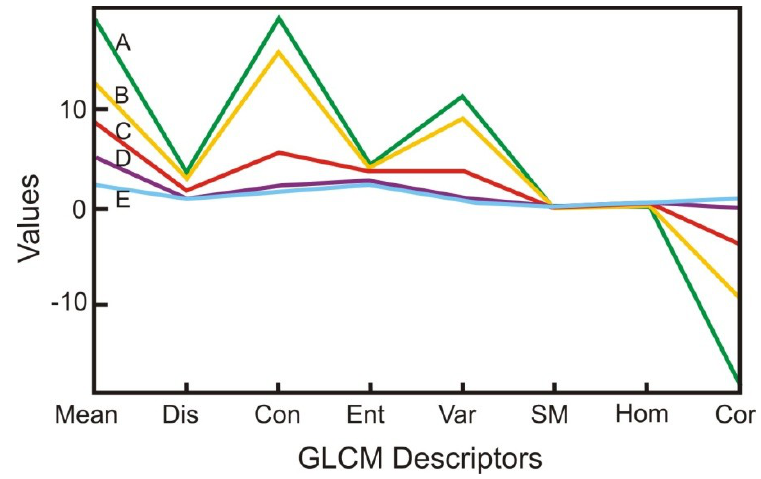
Figure 14. GLCM-descriptor signatures for the study area: (A) Curve A; (B) Curve B; (C) Curve C; (D) Curve D; and (E) Curve